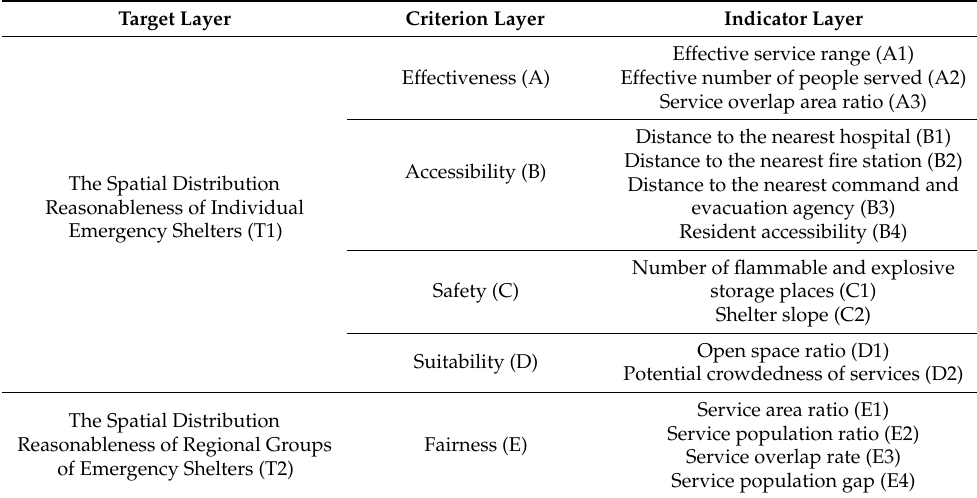
Table 3. Evaluation indicator